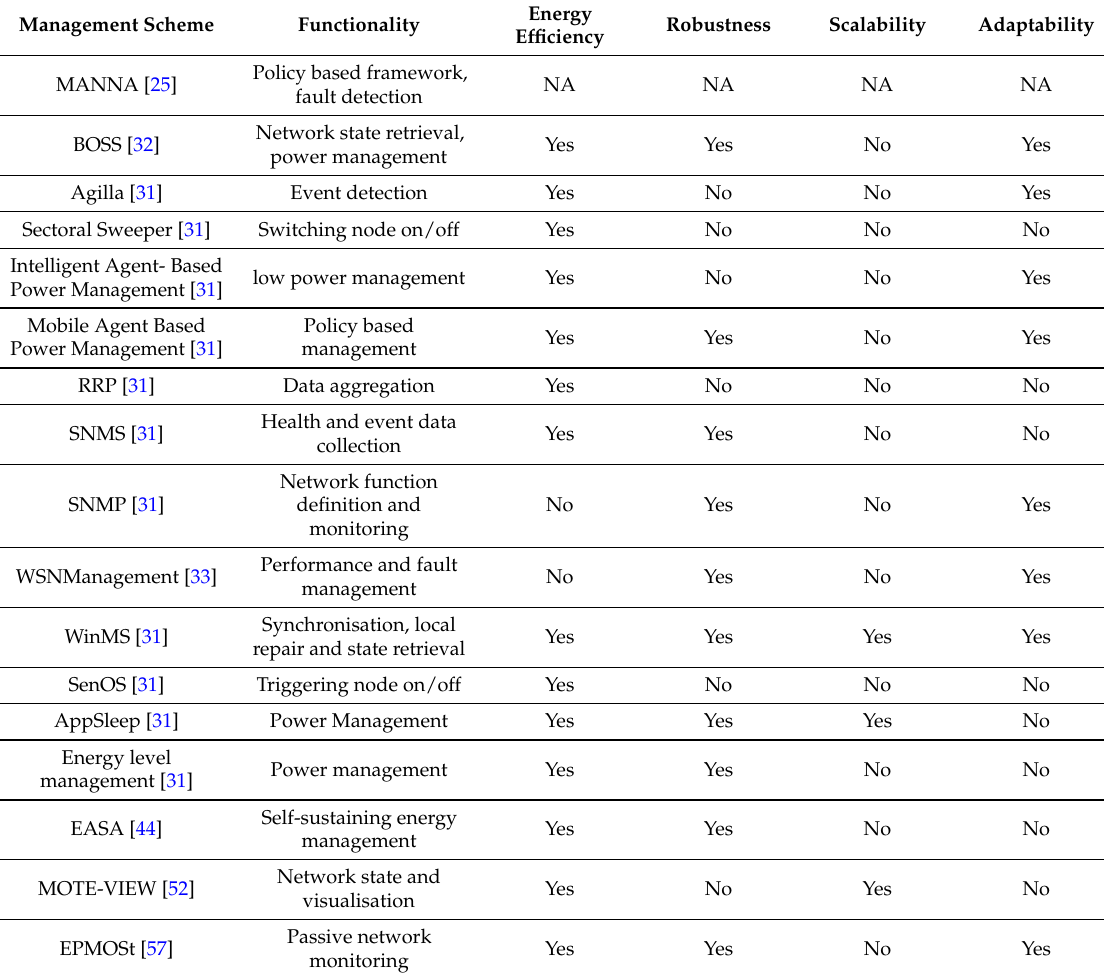
Table 1. Available WSN management systems evaluation against the design